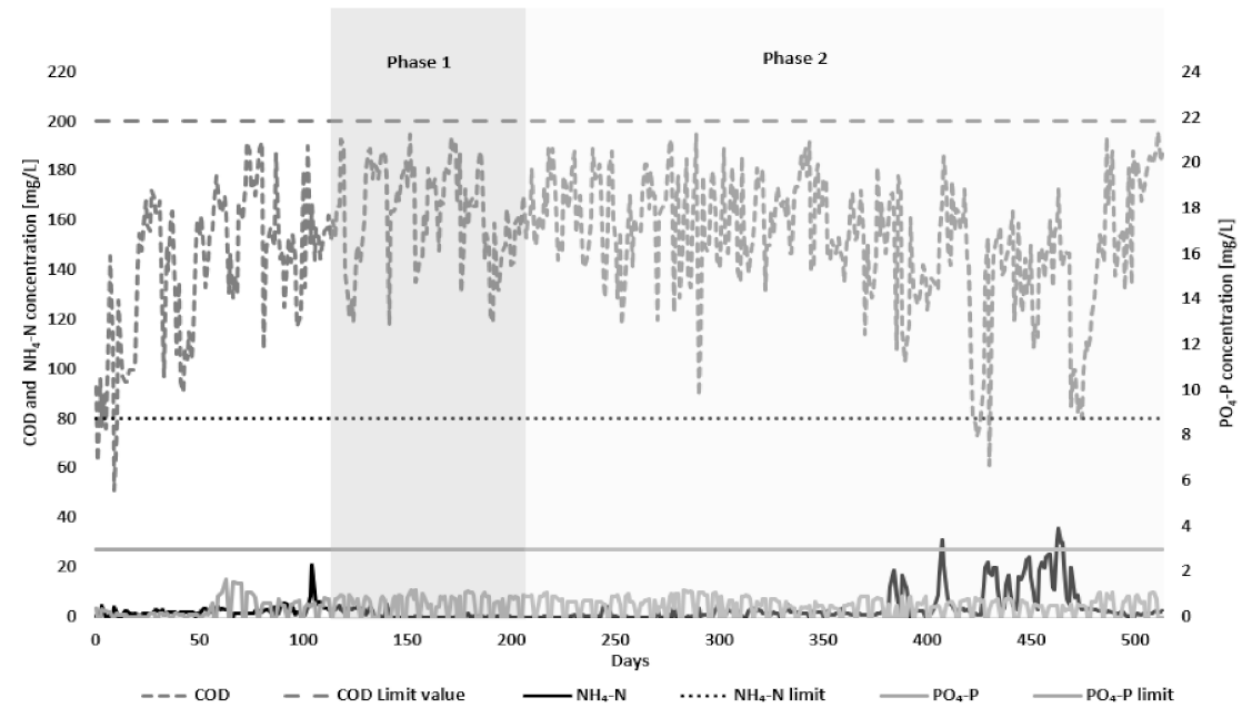
Figure 9. The process variables COD, NH 4 -N, NO 3 -N, and PO 4 -P in the outlet after activated carbon in the LLTP. (Limit values Annex 51: COD: 200 mg/L, NH 4 -N: 80 mg/L, and PO 4 -P: 3